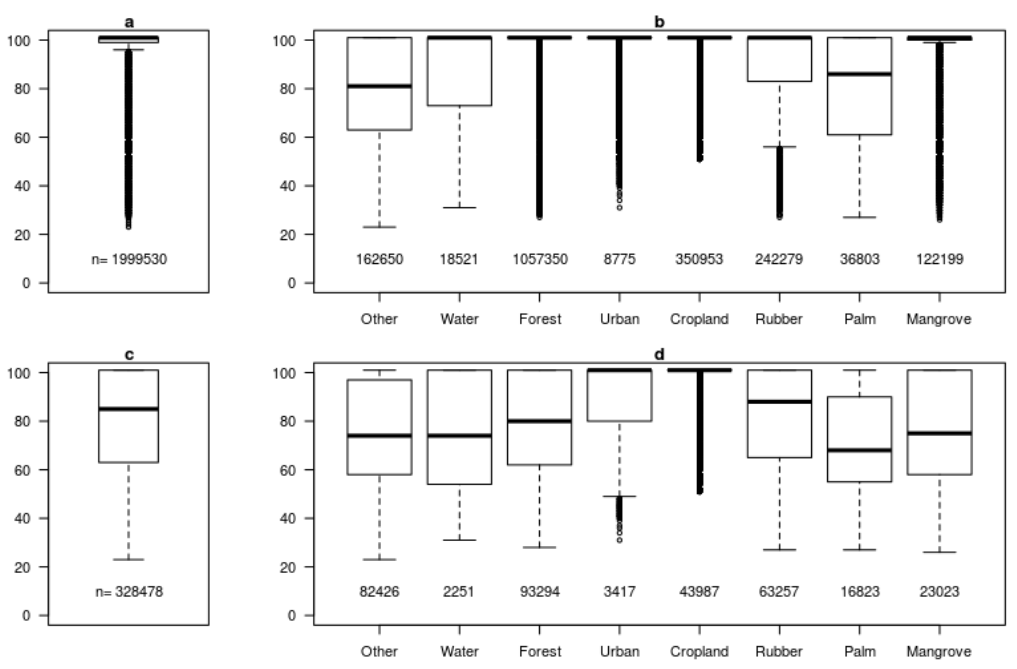
Figure 7. The distribution of the probabilities ( a ). The distributions of probabilities according to class ( b ). The distribution of probabilities for classes that change between 2017 and 2018 for all ( c ) and sorted by class ( d